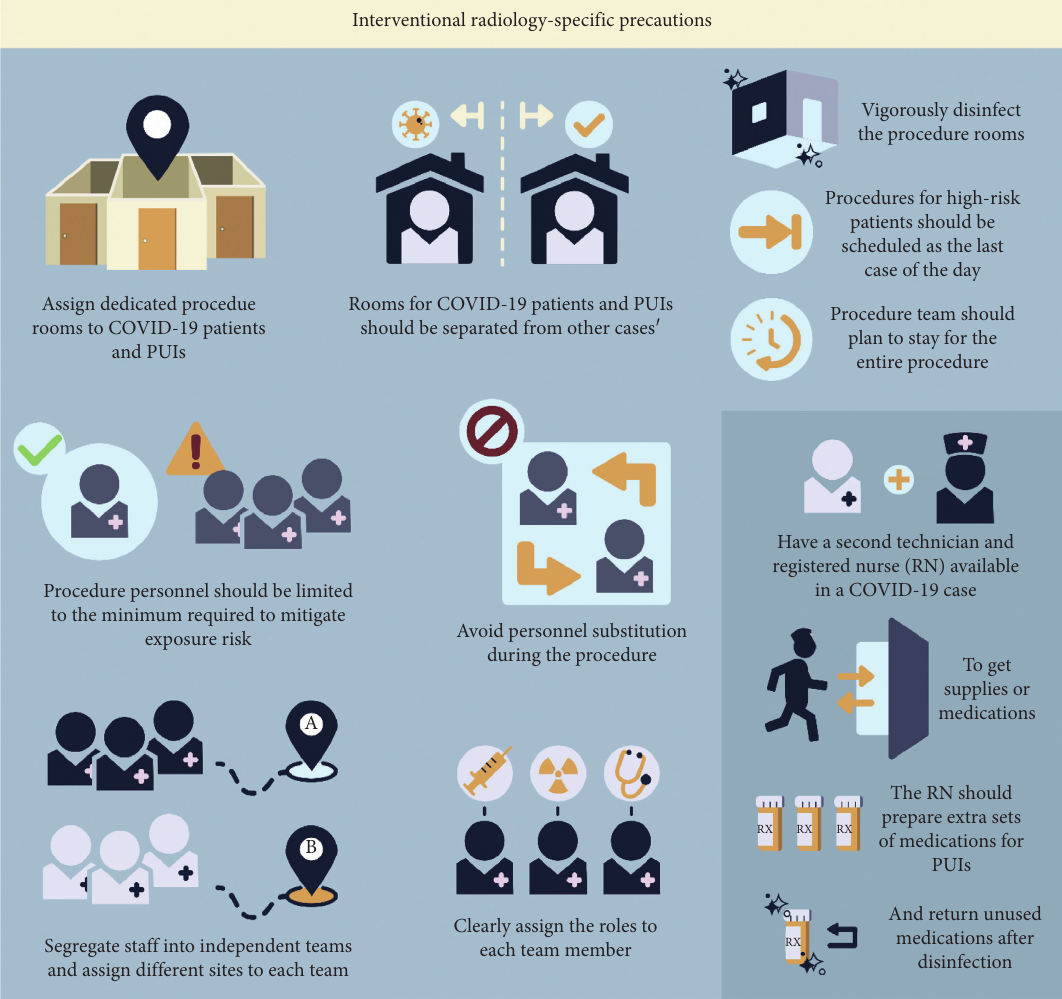
Figure 4: Proposed precautions for interventional radiology for COVID-19 outbreak based on the WHO and CDC recommendations and ongoing